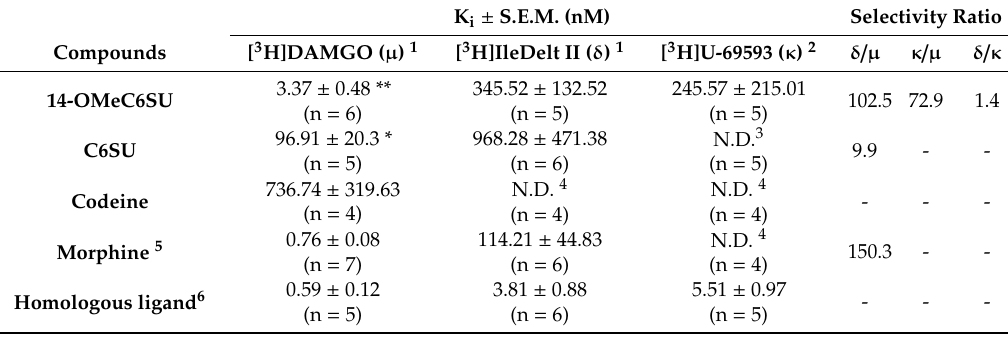
1 performed in rat brain membrane homogenates; 2 performed in guinea pig brain membrane homogenates; 3 the compound did not inhibit total specific radioligand binding (100%) to 50%, thus the K i value cannot be interpreted (N.D. not determined); 4 the compound did not alter significantly (One-sample t test) the total specific radioligand binding (100%), thus the K i value cannot be interpreted (N.D. not determined); 5 adopted from [23]; 6 indicates the unlabeled form of the radioligands and represent a control for the assay ( µ : DAMGO δ : IleDelt II, κ : U-69593); * compared to codeine (One-way ANOVA, with Sidak’s multiple comparison test; ** P < 0.01, *** P < 0.001).